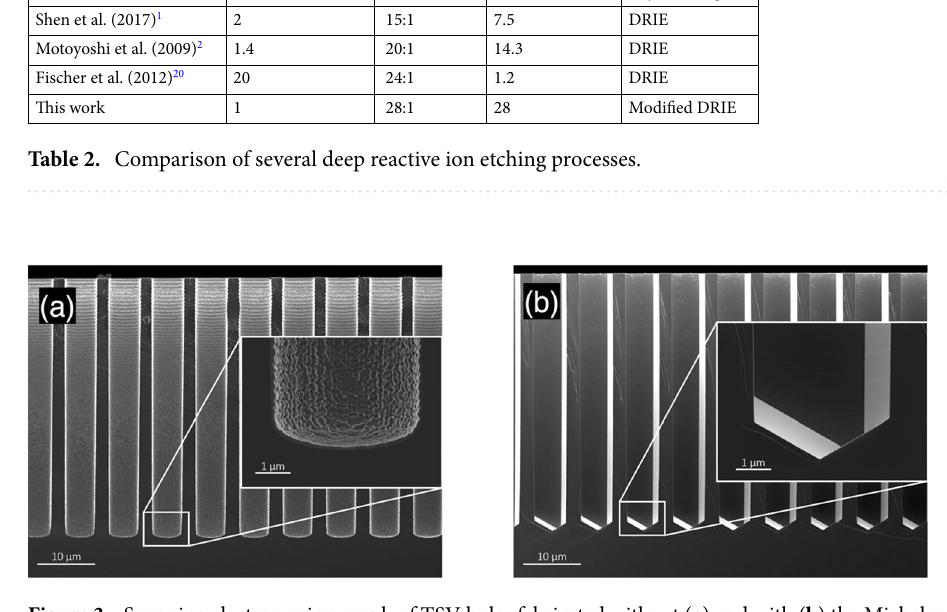
Figure 3. Scanning electron micrograph of TSV holes fabricated without ( a ) and with ( b ) the Michelangelo step. These holes here are 5 µm wide and 40 µm deep: at this aspect ratio, both scalloping and tapering effects are completely removed after immersing the wafer for 60 min in a potassium peroxide bath solution at 40% heated up to 60